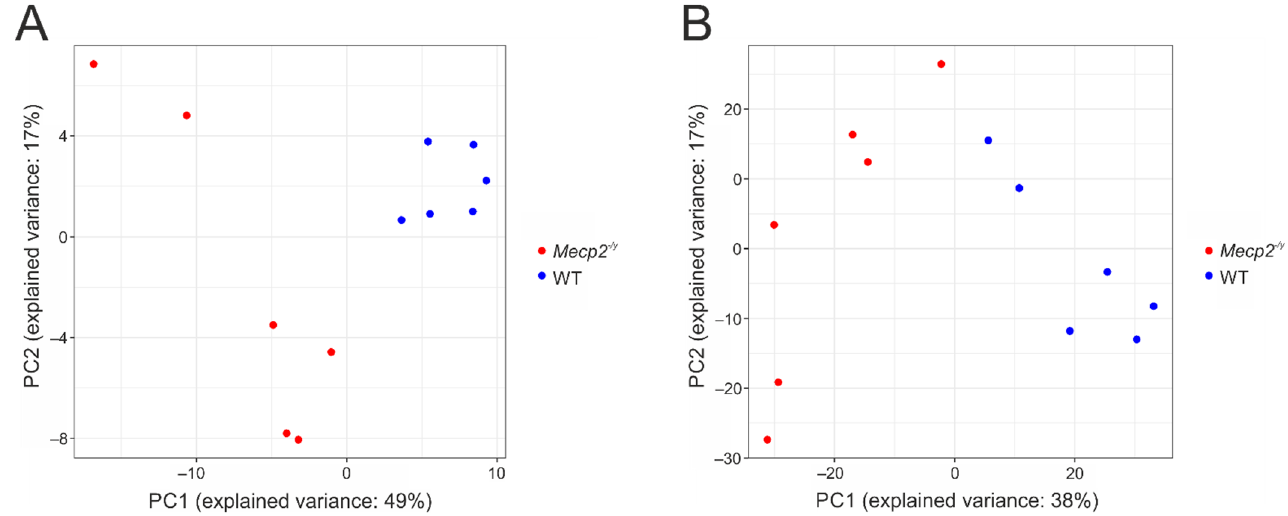
Figure 1. Principal component analysis (PCA) plots for Mecp2 − /y (red dots) and WT (blue dots) cortices. PCA is computed only on the identified metabolites ( A ), and over all measurements ( B ). Percentage of explained variance is reported for both x (first component) and y (second component) axis.